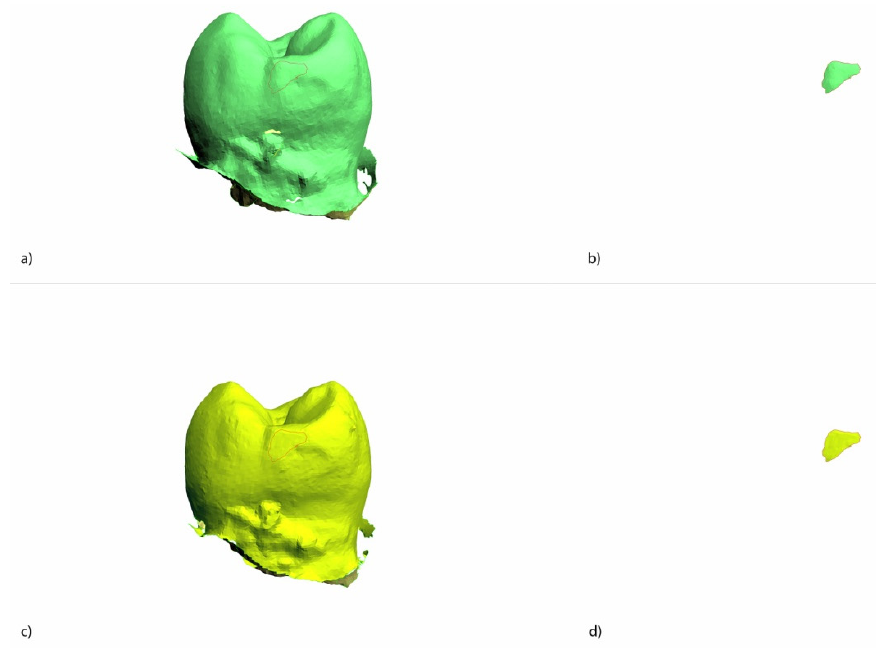
Figure 4. ( a ) Interproximal view of the individually segmented tooth 3.4 of the preoperative STL ( b ) with the isolated interproximal examel reduction area. ( c ) Interproximal view of the individually segmented tooth 3.4 of the postoperative STL ( d ) with the isolated interproximal examel reduction area.